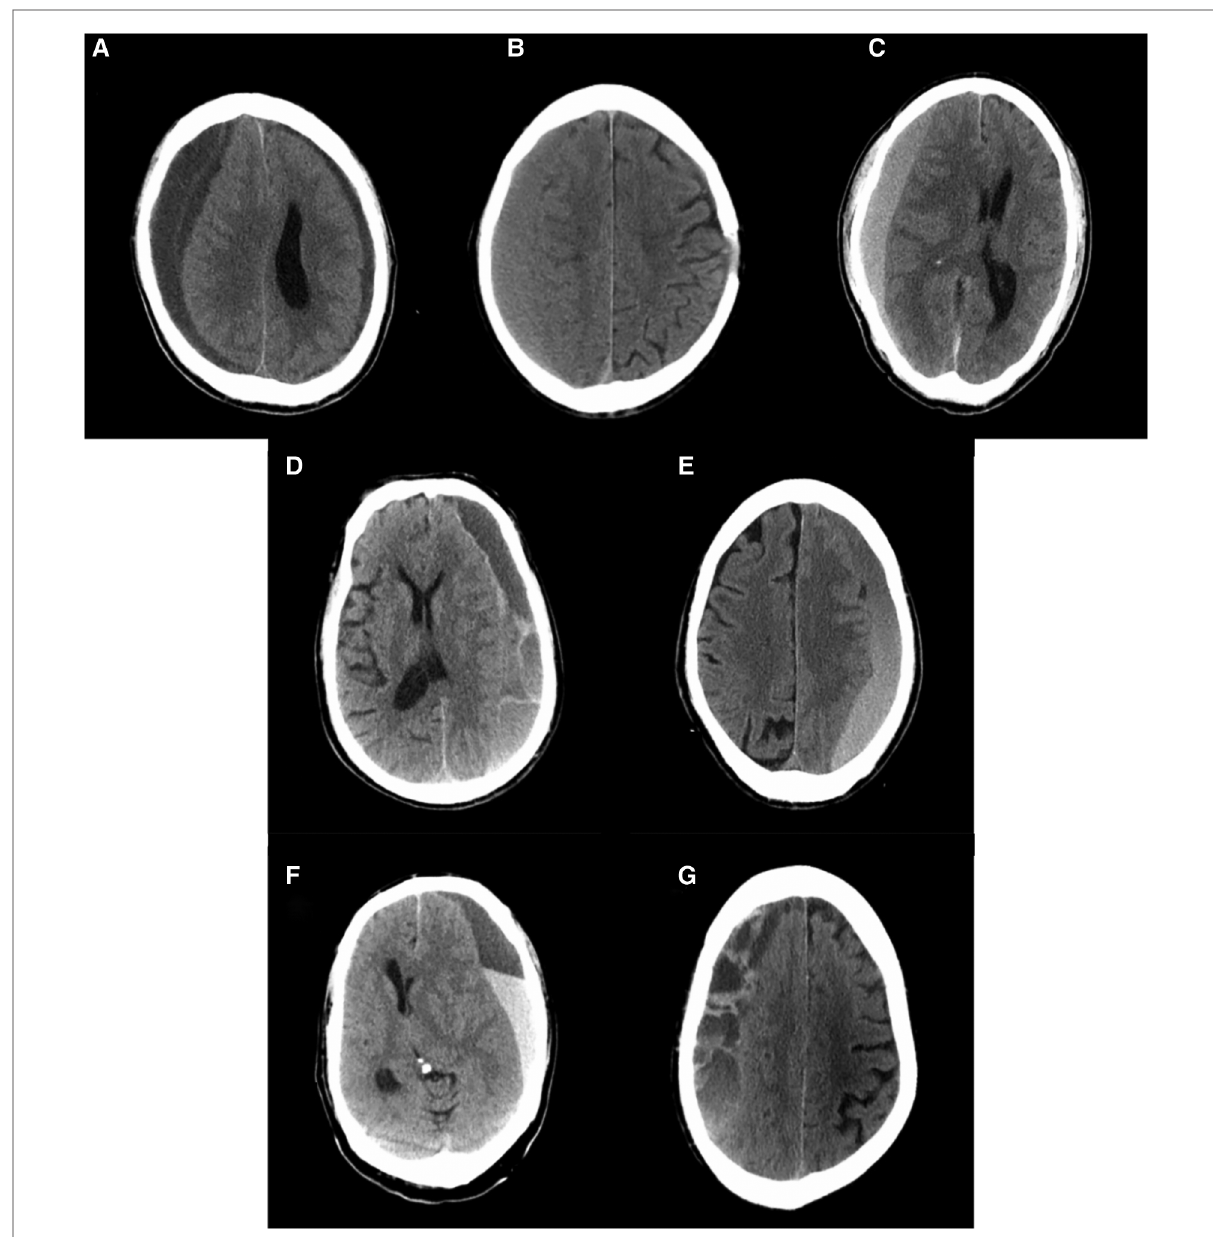
FIGURE 1 Computerized tomography scans of representative cases with chronic subdural hematomas according to their internal architectures described by Nakaguchi et al. (15). ( A ) Homogenous hypodense, ( B ) homogenous isodense, ( C ) homogenous hyperdense, ( D ) laminar type, ( E ) gradation type, ( F ) separated type, and ( G ) trabecular